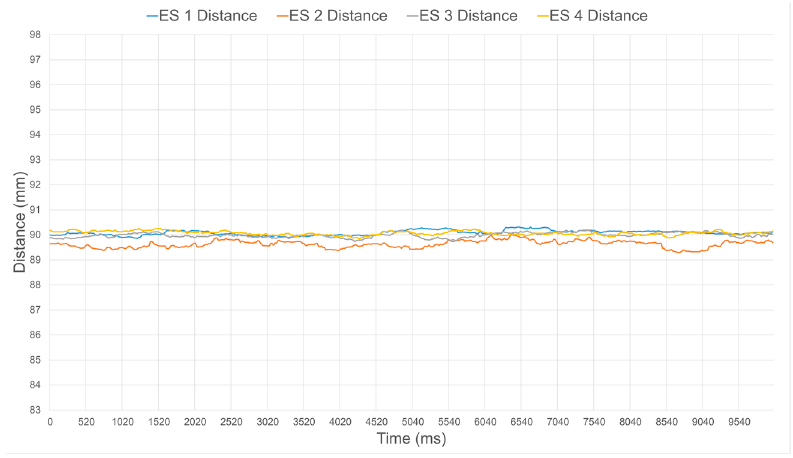
Figure 17. Calibrated distance estimates from four IR range sensors for ground truth distance of a surface located 90 mm in front of the compliant wrist.